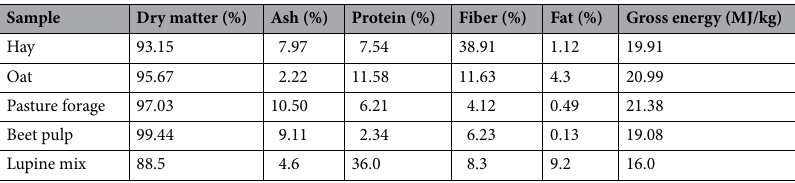
Table 6. The feed ration was consistent with the Polish standards—based on INRA method 47 . Sample collection and storage.